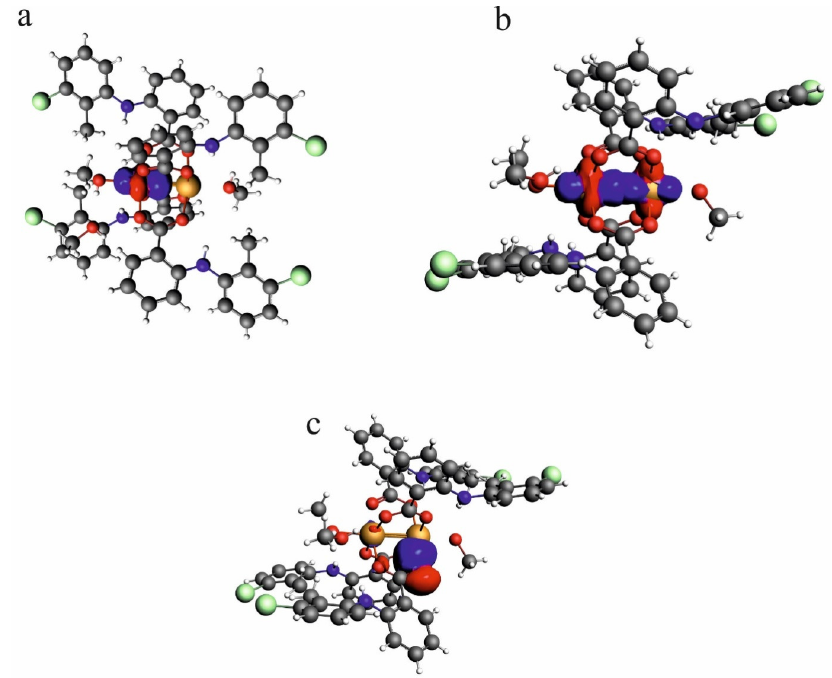
Figure 6. NLMO orbitals for lone pair on one of the Cu 2+ cations in the investigated compound— [Cu II 2 (Tolf) 4 (MeOH) 2 ] · 2MeOH ( a ), the weak interaction formed by lone pairs of two Cu 2+ cations ( b ), lone pairs on the oxygen atom which is engaged in the interaction with Cu 2+ cation ( c ). HOMO and LUMO orbitals for Cu II 2 (Tolf) 4 (MeOH) 2 ] · 2MeOH, QEBQIX, and